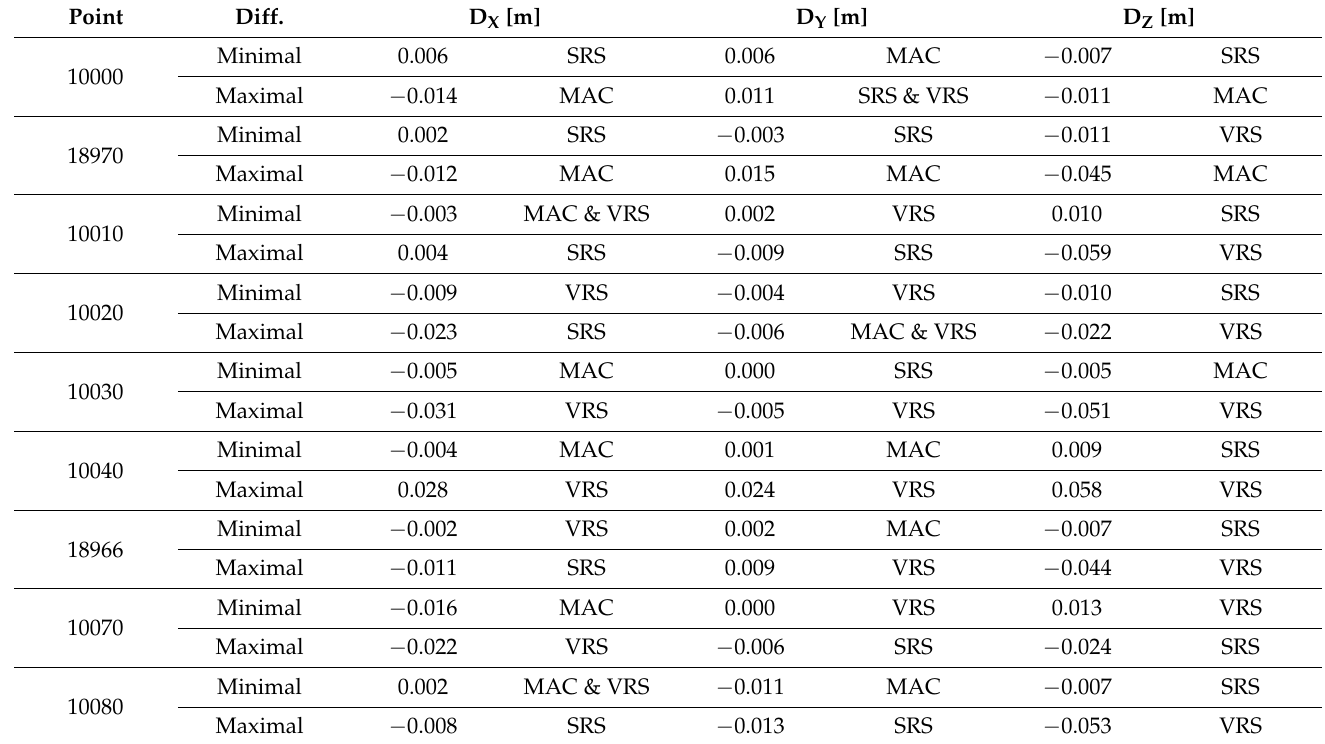
Table 5. Differences of coordinates after applying GNSS static occupation and with the use of real-time technique measurements.